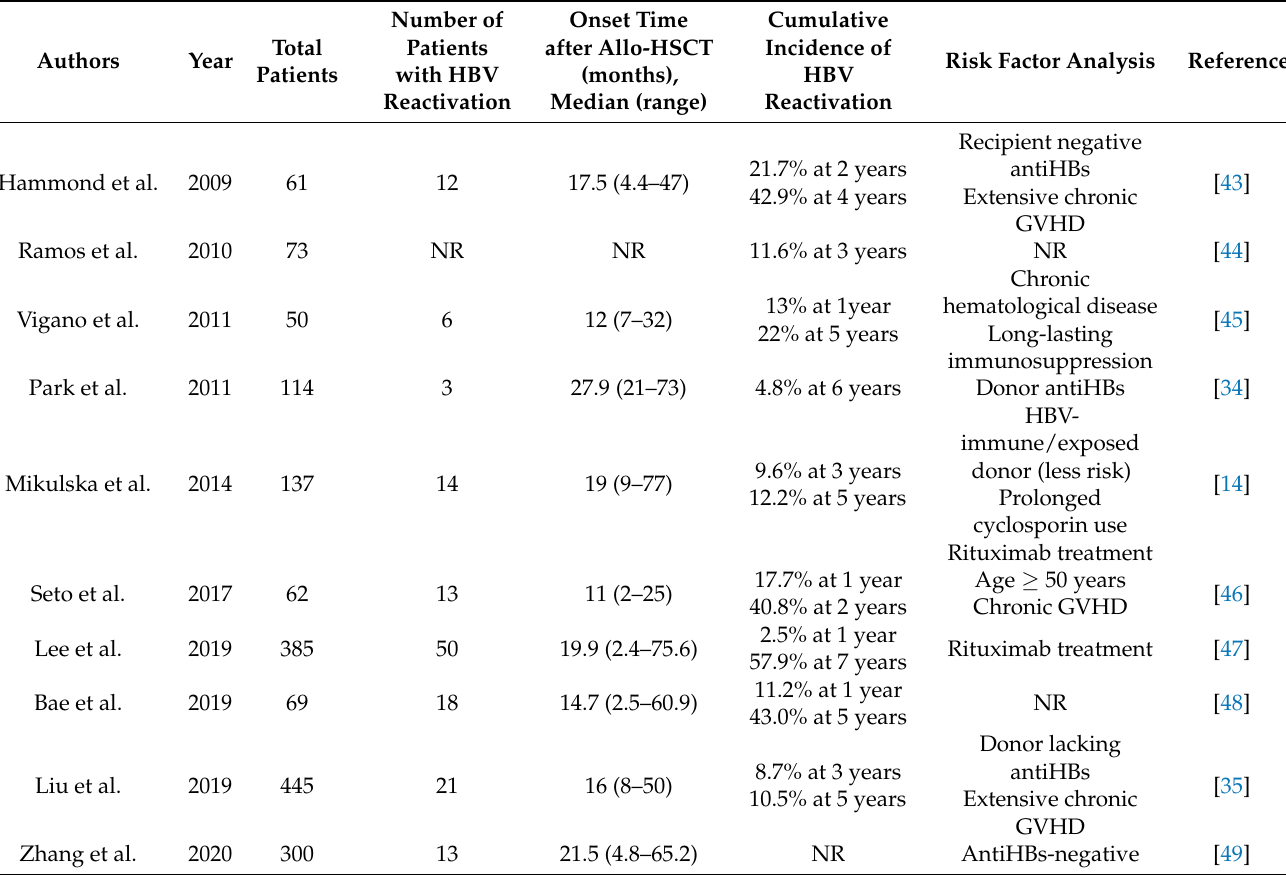
Table 2. HBV reactivation in patients with HBsAg-negative, antiHBc-positive patients receiving